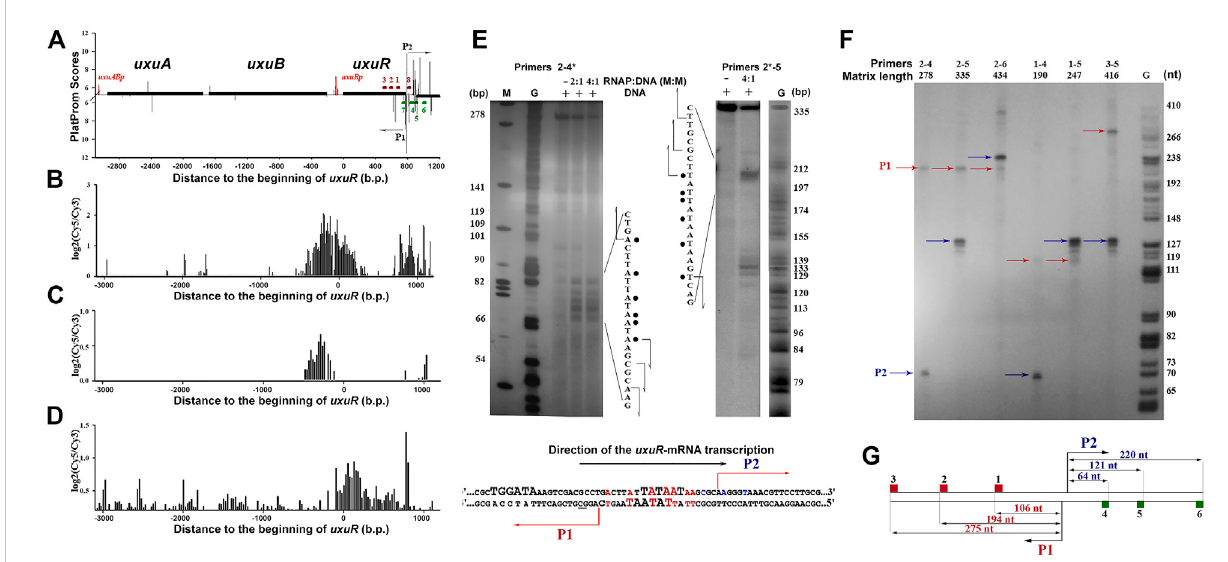
FIGURE 2 (A) Computational mapping reveals multiple promoters near the uxuR gene. Solid black lines above or below the X -axis show positioning and orientation of the genes. Bars represent promoters predicted on both strands. Oligonucleotides used in this work are shown by dark red and green rectangles (See Supplementary Table S2). (B) and (C) Distribution of the RNA polymerase binding sites in the uxuR region as estimated by the ChIP-chip technique (Herring et al., 2005; Reppas et al., 2006, respectively). (D) Expression ef fi ciency data obtained in (Cold Spring Harbor Lab, 2023). (E) Permanganate footprinting of RNA polymerase complexes with the DNA fragment of the uxuR gene containing predicted promoters P1 and P2. Radioactive 32 P-ATP was incorporated in the 5 ′ -end of primer 4 (left gel) or primer 2 (right gel). Gels were calibrated with G-speci fi c sequencing of the samefragments.The respective nucleotide sequences ofeachstrandareshown. Modi fi edthymines are markedwith points. Predicted transcriptionstart sites are indicated with arrows. Below is a schematic representation of P1 and P2 positioning in the uxuR sequence. − 10 elements are set in bold